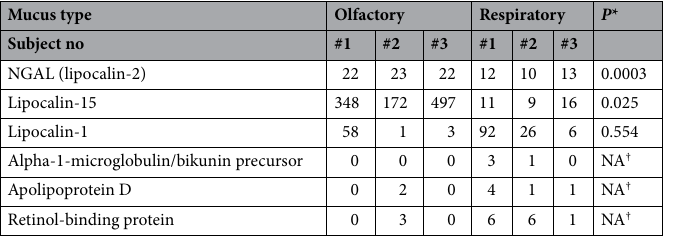
Table 2. Lipocalin counts in proteome analysis of mucus. The value in each cell indicates the total mass spectrum counts used to identify proteins. *non-paired t test. † NA: not assessed because of low abundance.